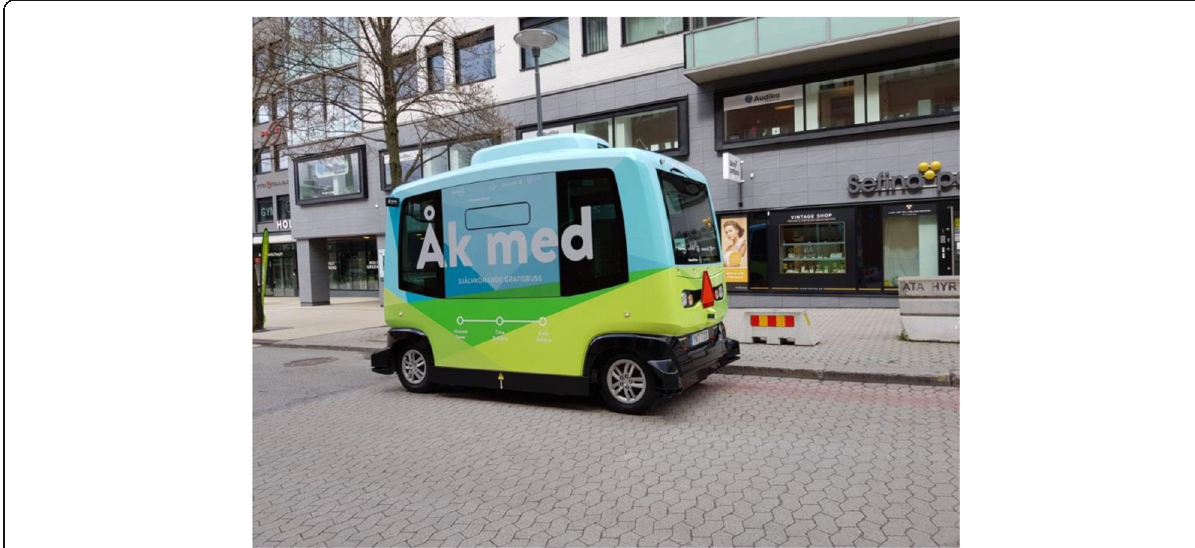
Fig. 3 Picture featuring EZ10, the small automated vehicle used in the trial operation in Kista, Stockholm [photo taken on 4th May 2018 by SARA1 research